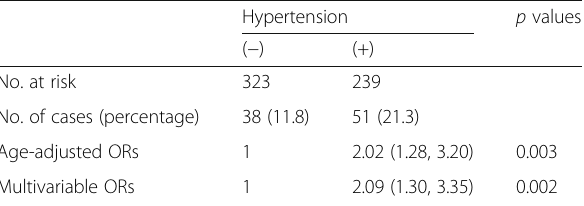
Table 2 Odds ratios (ORs) and 95% confidence intervals (CIs) for atherosclerosis